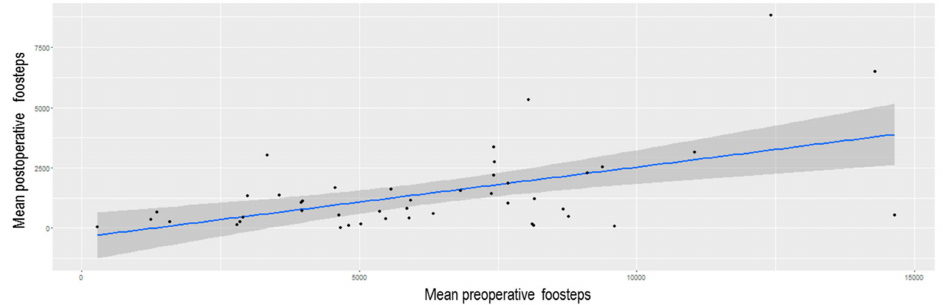
Figure 3. Correlation between preoperative footsteps and postoperative footsteps. r =